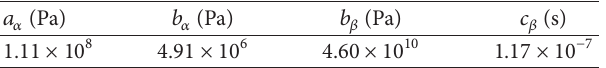
Figure 12: Identification of the yield stress using the Ree-Eyring model and the modified Eyring model. Table 1: Material constants of Ree-Eyring equation.